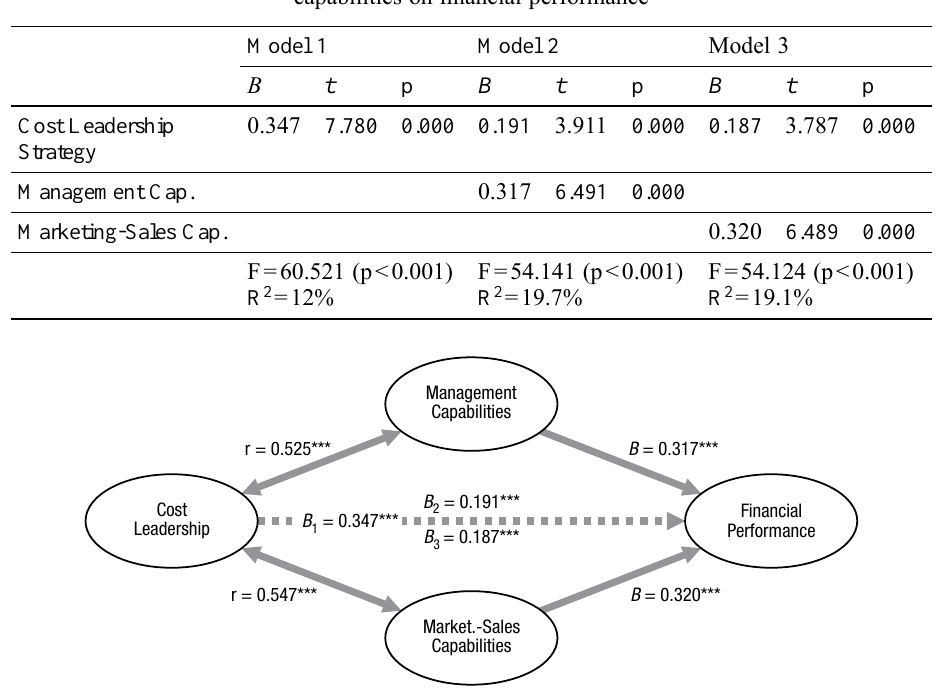
Table 7. The total effects of cost leadership strategy, management and marketing-sales